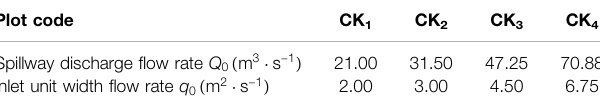
TABLE 1 | Calculation of hydraulic elements under different working